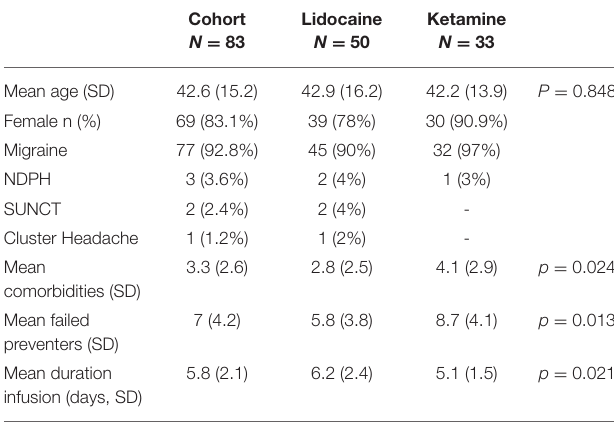
TABLE 1 | Baseline characteristics of patient